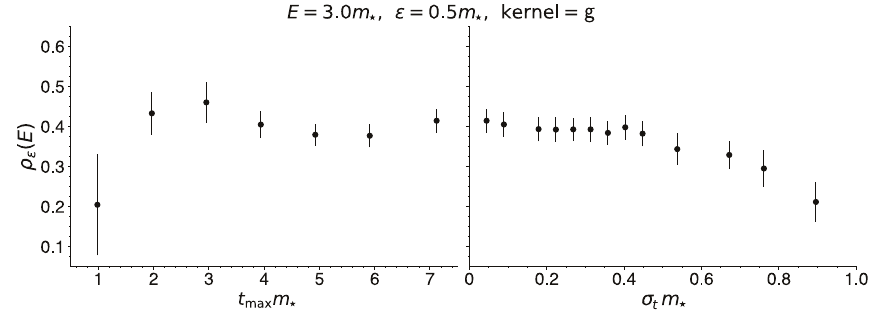
Figure 3 . Left : test of the sensitivity of the reconstruction procedure to the range of time slices [ τ min , τ max ] by varying τ max , plotted using t max m ? = τ max ( am ? ) with fixed τ min = 1 . Right : test of the sensitivity to the spacing between time slices included in the reconstruction σ t . Both tests are performed on the A1 ensemble detailed in table 2. Evidently the reconstruction procedure is relatively stable under the variation of σ t and τ max